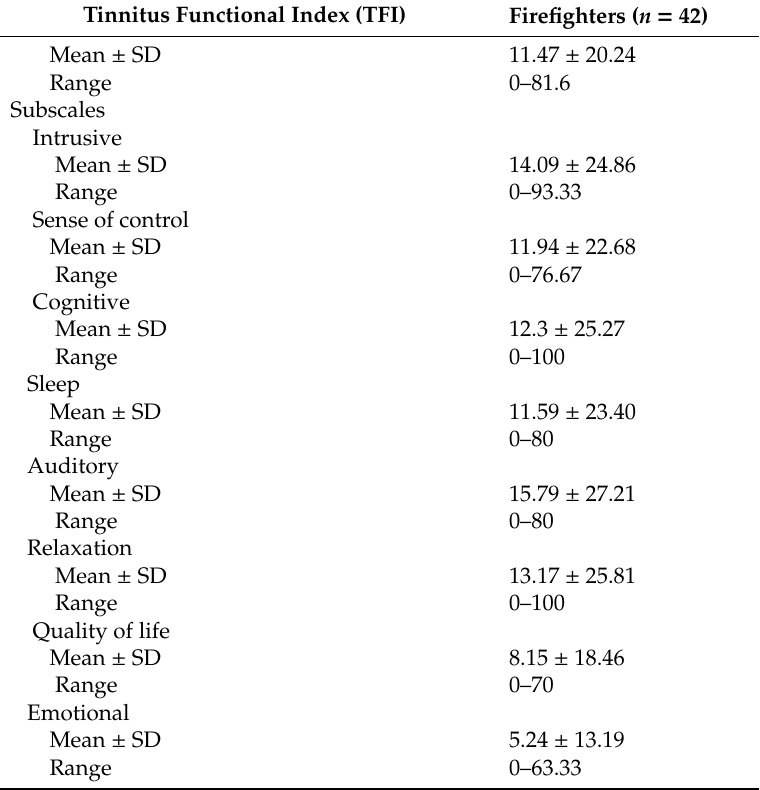
Table 3. Tinnitus functional index scores.